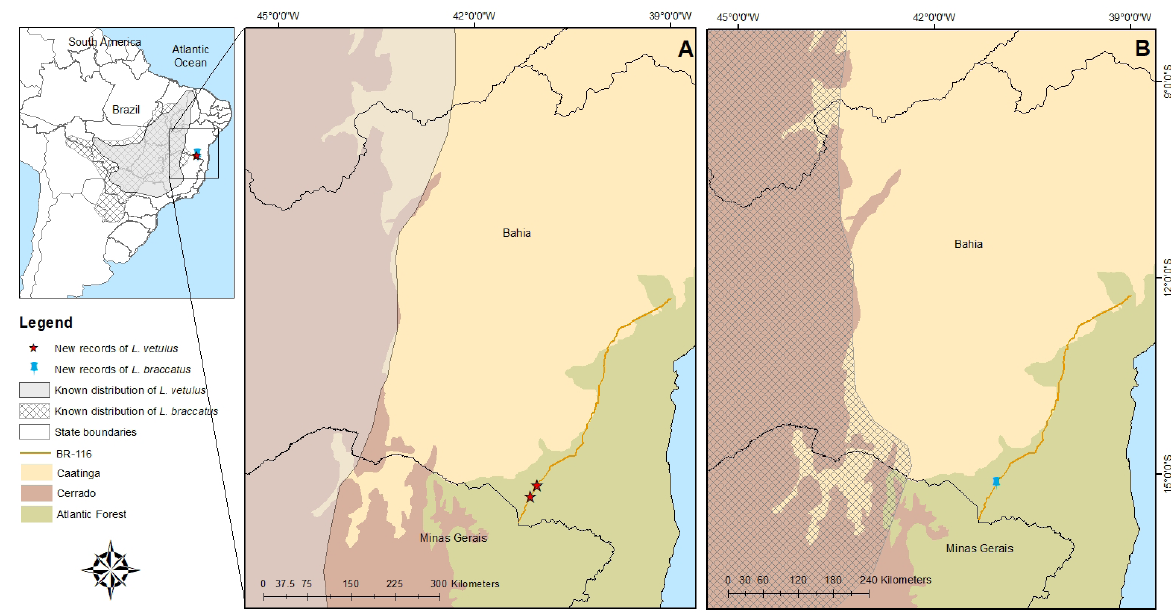
Figure 1. New records (2016 and 2017) based on roadkilled specimens, and the global distributions of ( A ) Lycalopex vetulus (based on Lemos et al. 2020) and ( B ) Leopardus braccatus (based on Nascimento et al.